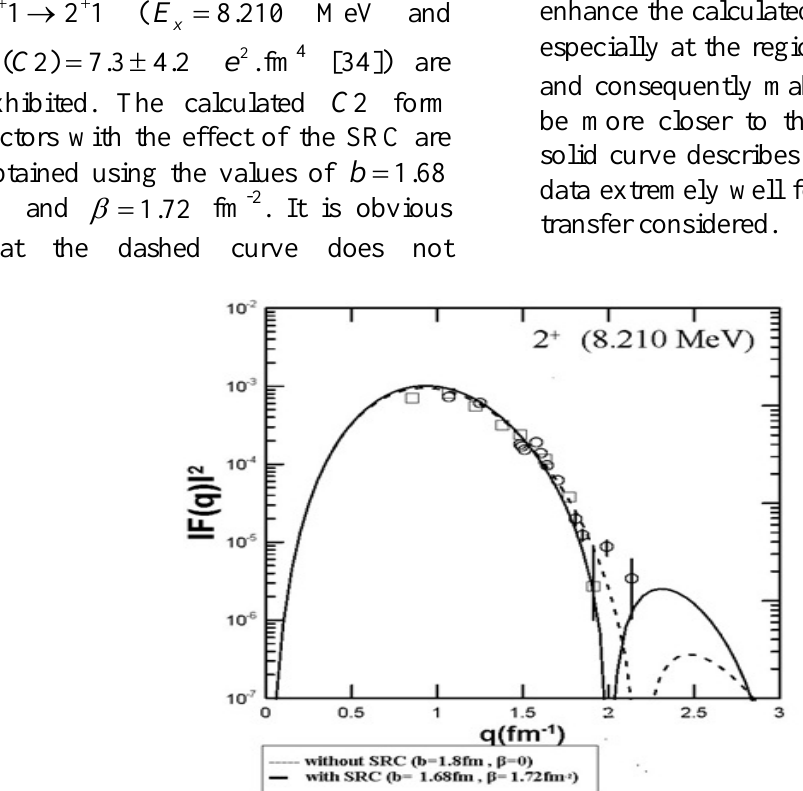
Fig. 4: The inelastic longitudinal 2 C form factors for transition to the 12 + (8.210 MeV) state. The dashed and solid curves are the calculated 2 C form factors without and with the inclusion of the effect of the SRC, respectively. The open square and open circle symbols are the experimental data taken from